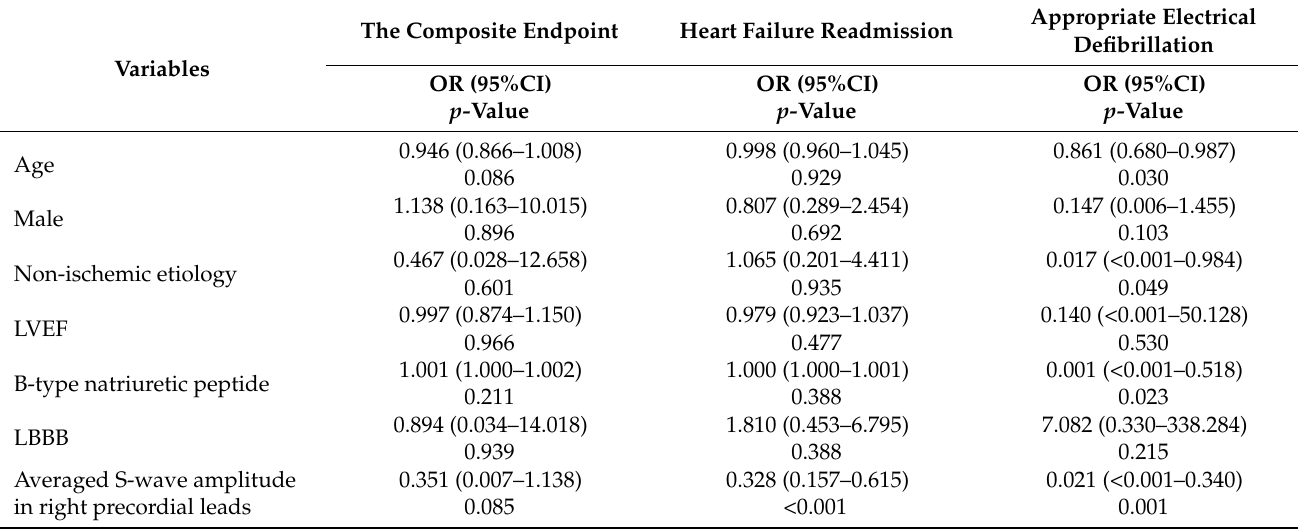
Figure 4. Cumulative incidence of clinical events stratified by the cutoff of S-wave amplitude among those without left bundle branch block (( A ) the composite endpoint of cardiovascular death, a heart transplantation, or a left ventricular assist device implantation; ( B ) heart failure readmission; ( C ) appropriate ICD therapy).